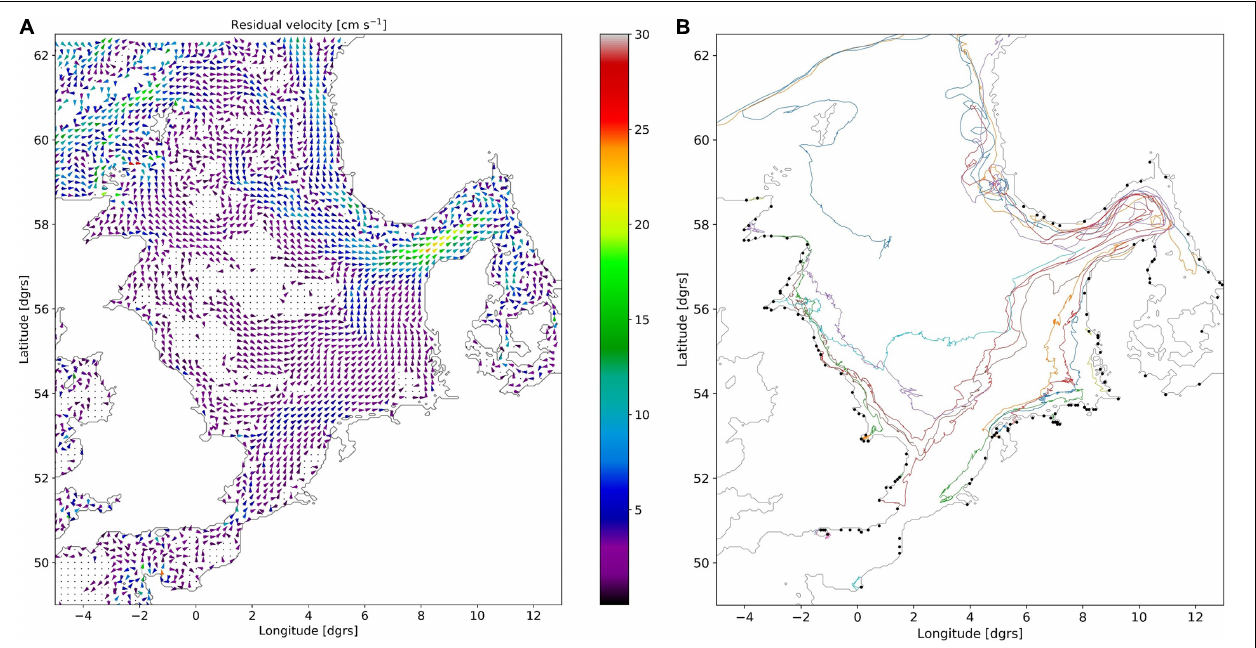
FIGURE 2 | (A) Modeled depth-averaged residual velocity (in cm s − 1 ) in the North Sea for 1983. Every third grid cell was plotted, and velocities smaller than 1 cm s − 1 were omitted to highlight the overall pattern. (B) Tracks of neutrally buoyant particles released at river mouths on 1 January 2017, until 30 December 2017. The colors indicate tracks of individual particles, but note that spatially separated particle tracks may have the same color. For visibility, only every fifth track was plotted. The black dots are the river mouth locations. Directions of travel are generally in the direction of the residual